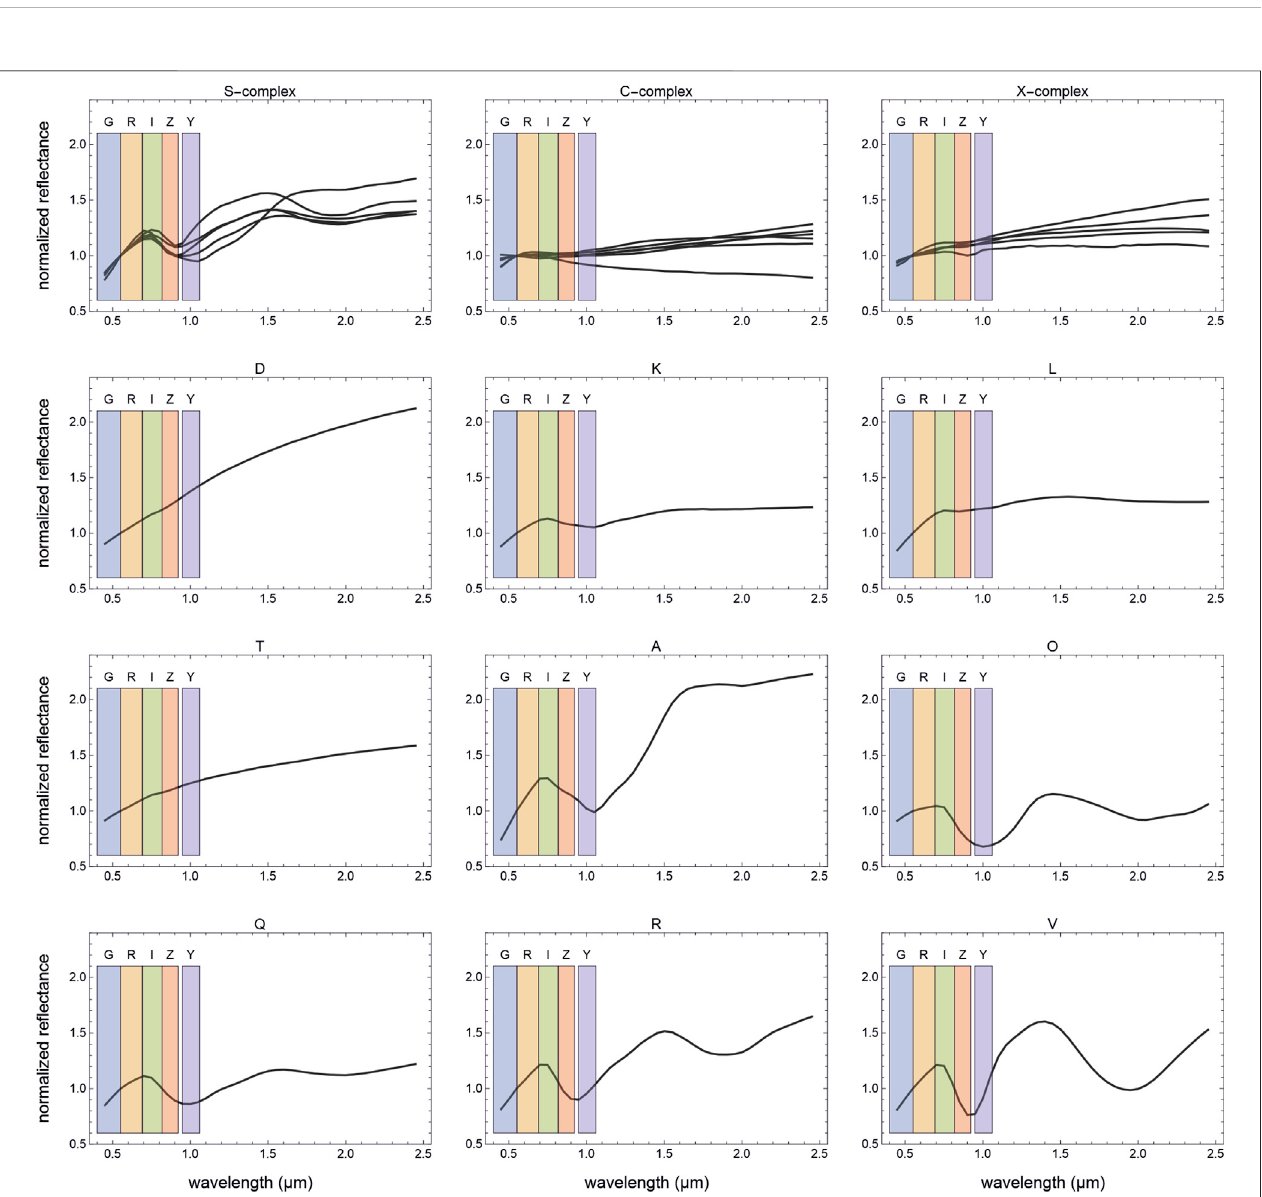
FIGURE 1 | Spectral behavior of the three taxonomic complexes and the nine endmember types in the Bus-DeMeo taxonomy. The average spectral behaviors of thetypesareshownwithblacksolidlines.ThewavelengthrangesfromwhichtheLSST fi lters g , r , i , z ,and y integratethesignalareshowninthebackgroundwithcolored rectangles. The spectral curves are normalized to unity at 0.55-µm wavelength.